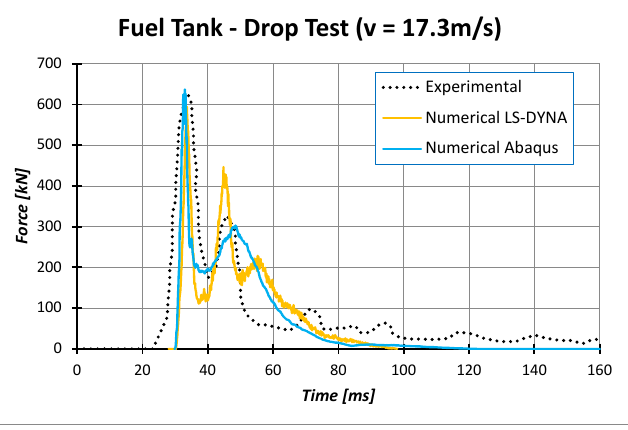
Figure 9. Numerical–experimental comparison in terms of impact force time-history.